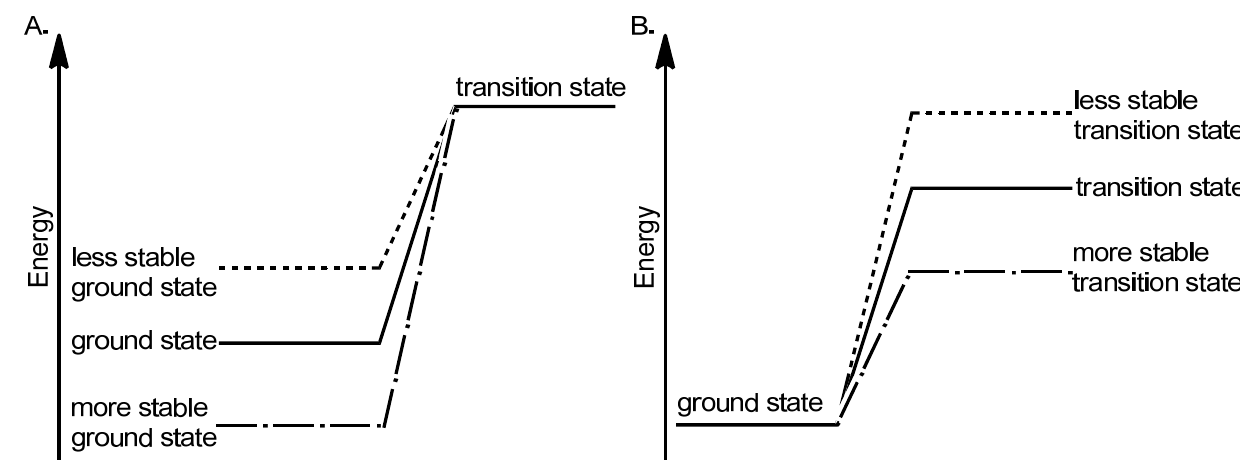
Figure 3. Ground and transition states of the water-exchange process. A. Stabilization and destabilization of the ground state lead to slower and faster water exchange-rates, respectively. B. Stabilization and destabilization of the transition state lead to faster and slower water-exchange rates,